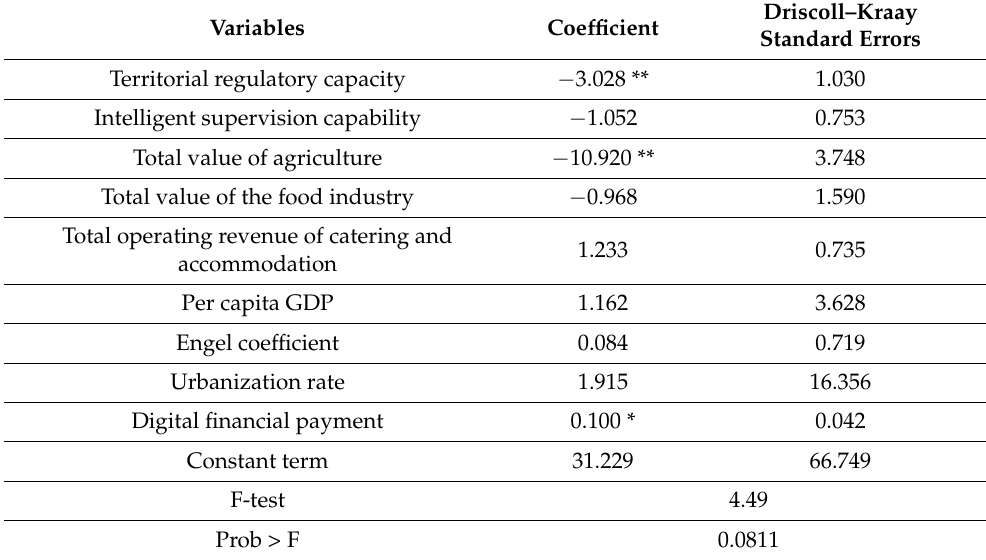
Table 11. Robust